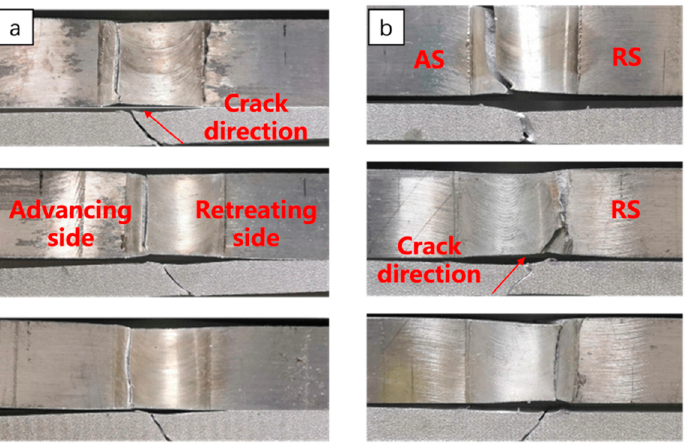
Figure 5. Macroscopic appearance of fracture location of welded joint: ( a ) FSW; ( b )